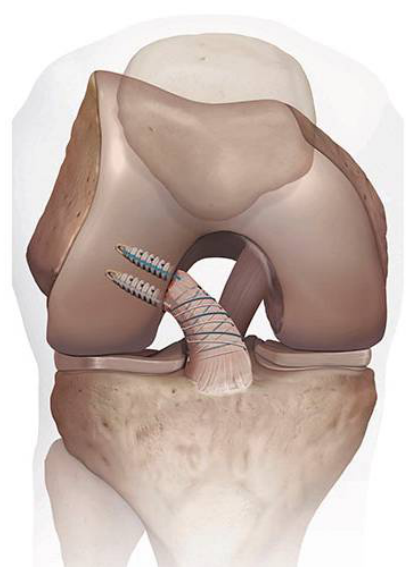
Figure 3. Suture anchor primary anterior cruciate ligament (ACL) repair of the right knee, frontal view. This image can be found in the “ACL Primary Repair Surgical Technique” brochure, Arthrex